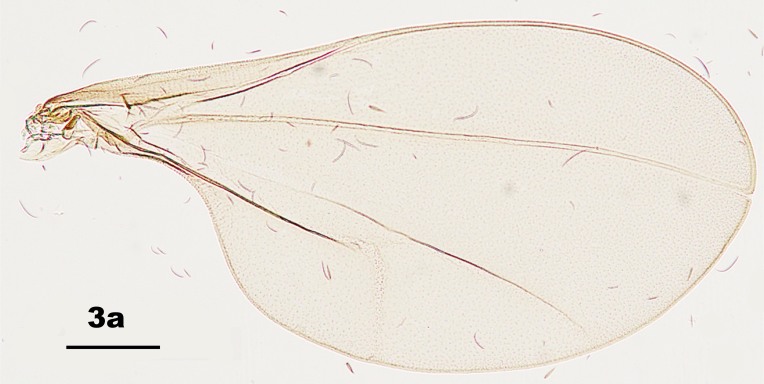
P.
tominagai n. sp.